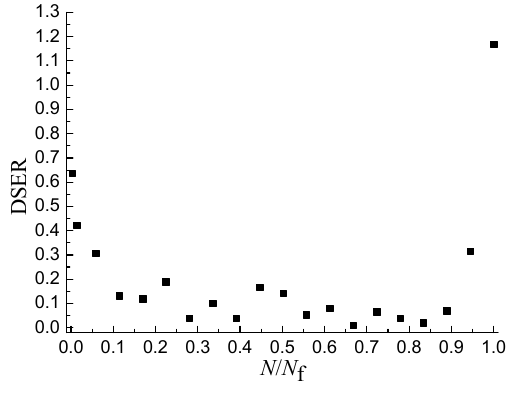
Figure 10. D - N / N f curve.